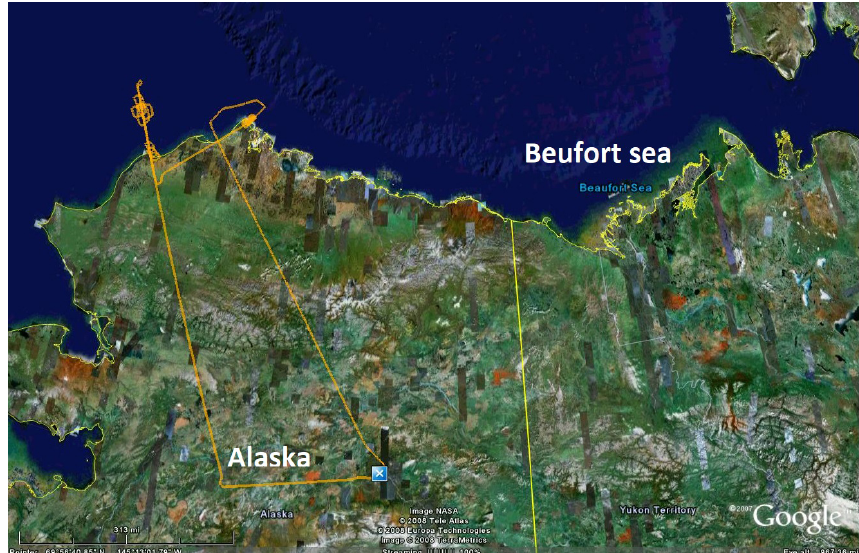
Figure 1. Flight track of P-3B airplane carrying NASA’s Cloud Absorption Radiometer (CAR) on 7 April 2008 during the Arctic Research of the Composition of the Troposphere from Aircraft and Satellite (ARCTAS) campaign (figure adapted from: https://www-air.larc.nasa. gov/missions/arctas/arctas.html, last access: November 2020). Image credits: ©NASA; ©Tele Atlas2008; ©Europa Technologies 2008;